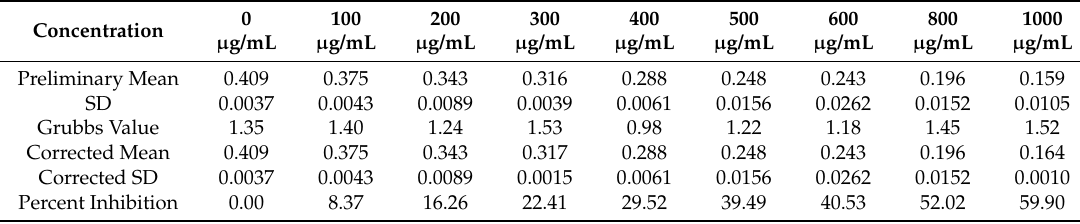
Table 2. DPPH assay raw absorbance data and calculated values for C. longa.